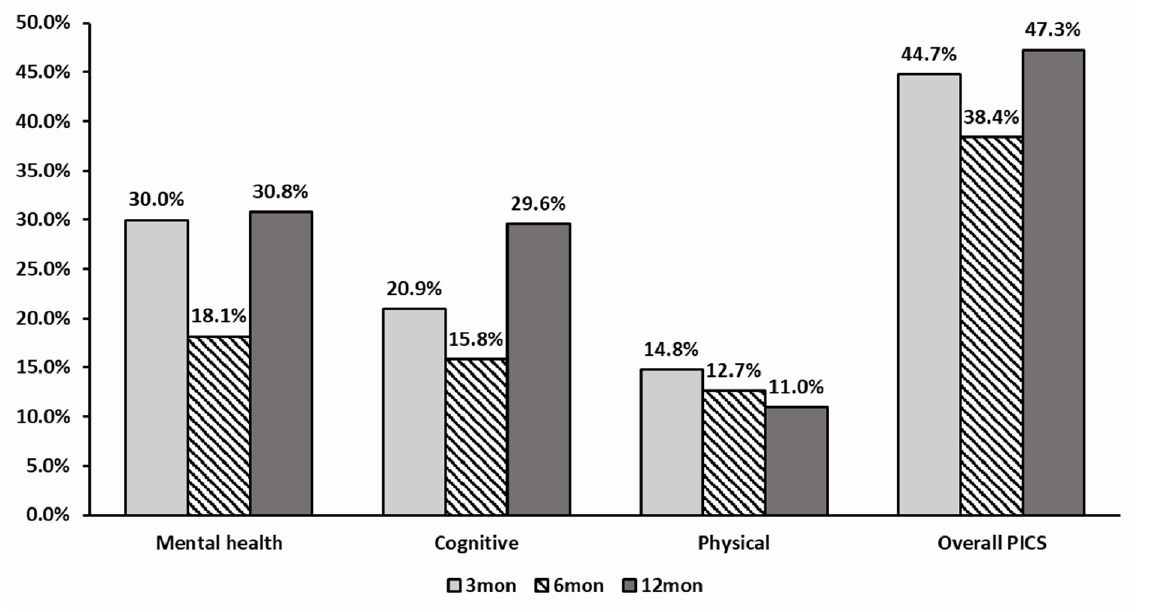
Figure 2. Prevalence of post-intensive care syndrome at 3, 6, and 12 months after discharge. Table 2. Changes in scores of PICS variables according to the time after discharge.